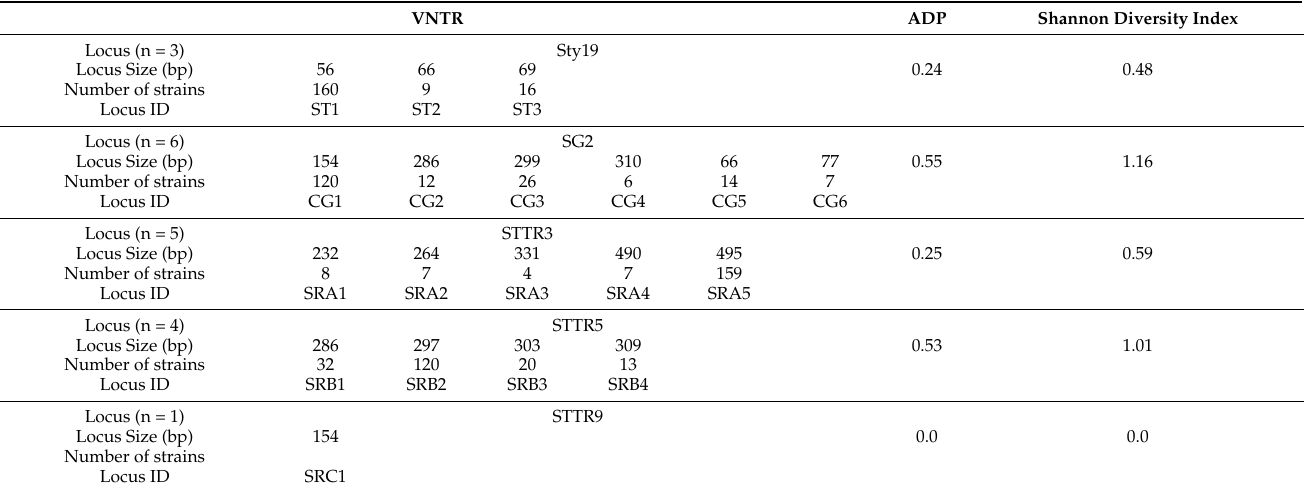
Table 3. Allele discriminatory power (ADP), Shannon diversity index, number of S. Infantis strains, size, and identity (ID) for each variable-number of tandem repeat (VNTR) locus.